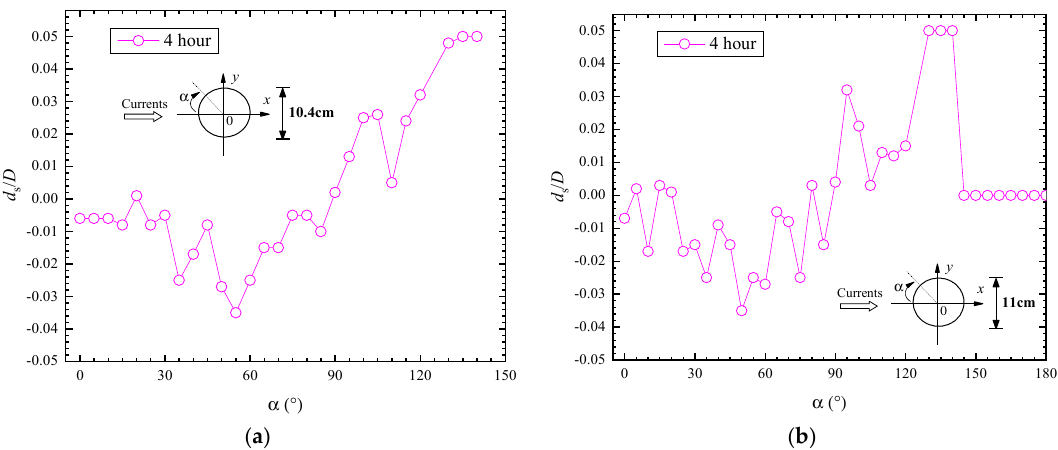
Figure 7. Evolutions of bed profiles. ( a – c ) are sections of test 1; ( d – f ) are sections of test 2.